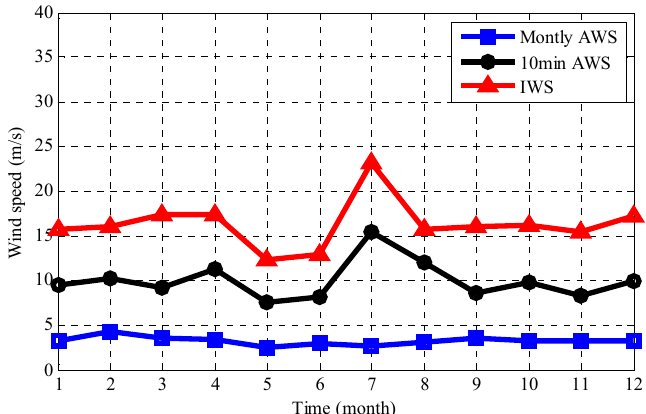
Table 3. Characteristics of the monthly wind speed in 2014.